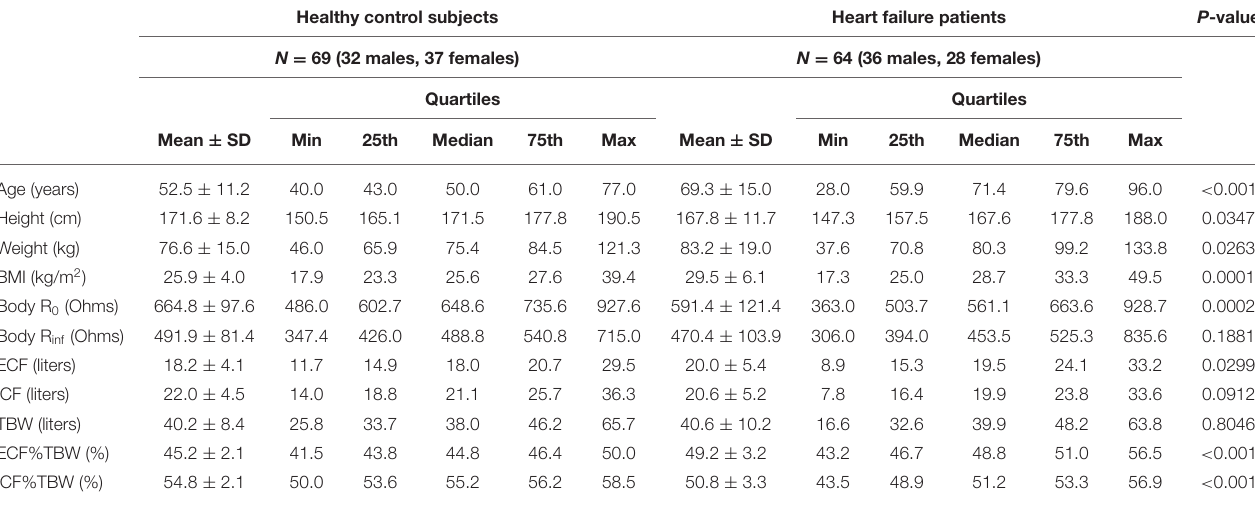
TABLE 3 | Age, physical characteristics, and bioimpedance spectroscopy